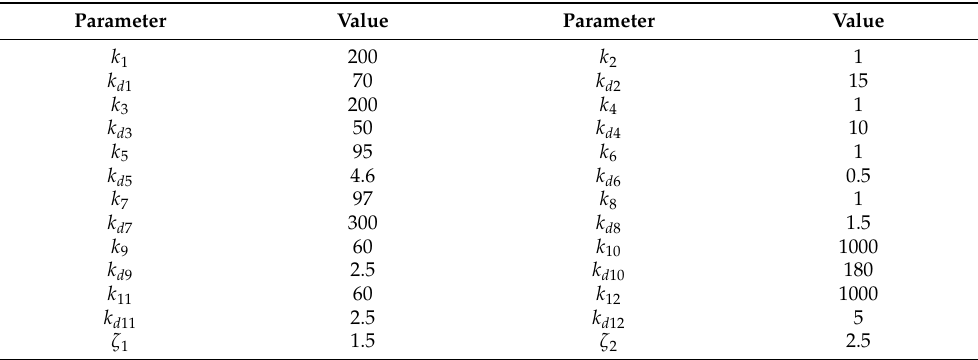
Table 2. Leader UAV control parameters for attitude, altitude and position loops.